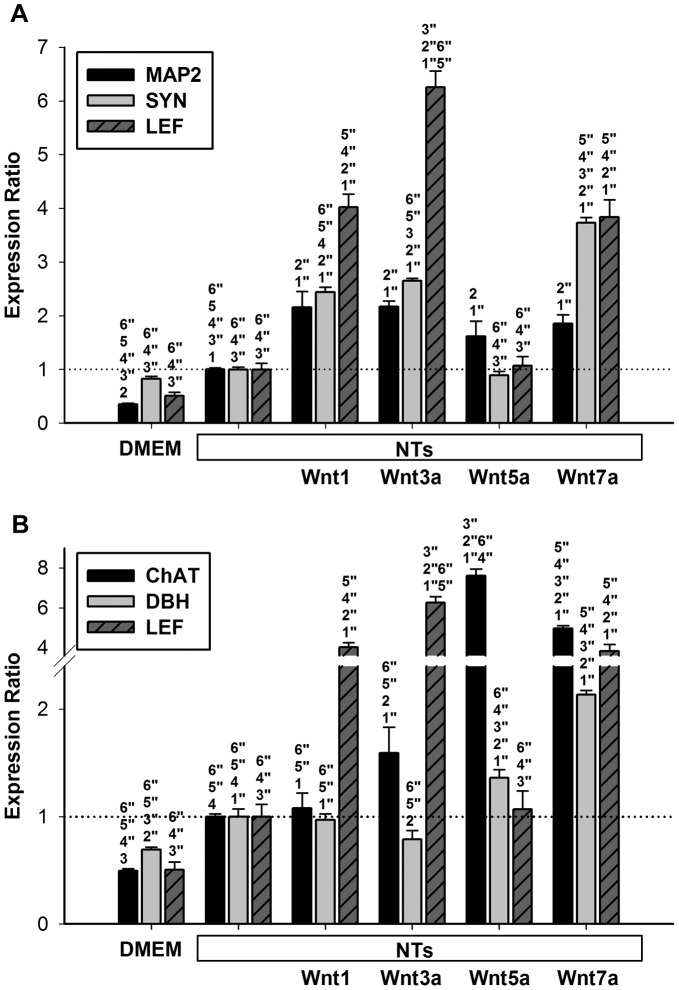
Neurogenic effects from different Wnts in NT-induced hMSCs.(A) mRNA levels of MAP2, SYN1, and LEF1 were quantified after 48 h of different Wnt treatments (2 µg/ml) in hMSCs that had been treated with NTs for 1 week. All Wnts promoted MAP2 expression, and Wnt7a induced the highest SYN1 expression. Levels were normalized to those of NTs treatments (set to 1.0). Data are presented as the mean ± SD of one triplicate experiment that was representative of three independent experiments. 1
p<0.05, 1″
p<0.01 (DMEM vs. all groups); 2
p<0.05, 2″
p<0.01 (NTs vs. all groups); 3
p<0.05, 3″
p<0.01 (Wnt1 vs. all groups); 4
p<0.05, 4″
p<0.01 (Wnt3a vs. all groups); 5
p<0.05, 5″
p<0.01 (Wnt5a vs. all groups); 6
p<0.05, 6″
p<0.01 (Wnt7a vs. all groups). (B) mRNA levels of ChAT, DBH, and LEF1 were quantified after 48 h of different Wnt treatments (2 µg/ml) in hMSCs that had been treated with NTs for 1 week. Wnt1 had no effects on ChAT or DBH expressions, but Wnt7a significantly induced both genes. Levels were normalized to those of NTs treatments (set to 1.0). Data are presented as the mean ± SD of one triplicate experiment that was representative of three independent experiments. 1
p<0.05, 1″
p<0.01 (DMEM vs. all groups); 2
p<0.05, 2″
p<0.01 (NTs vs. all groups); 3
p<0.05, 3″
p<0.01 (Wnt1 vs. all groups); 4
p<0.05, 4″
p<0.01 (Wnt3a vs. all groups); 5
p<0.05, 5″
p<0.01 (Wnt5a vs. all groups); 6
p<0.05, 6″
p<0.01 (Wnt7a vs. all groups).